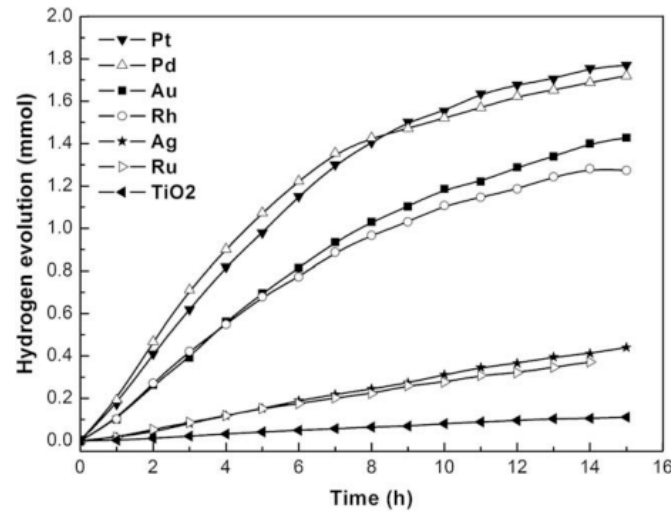
Figure 7. Effect of the kinds of noble ‐ metal ‐ loaded TiO 2 on hydrogen evolution. (Adapted from Ref. Figure 7. E ff ect of the kinds of noble-metal-loaded TiO 2 on hydrogen evolution. (Adapted from [85]). Ref.